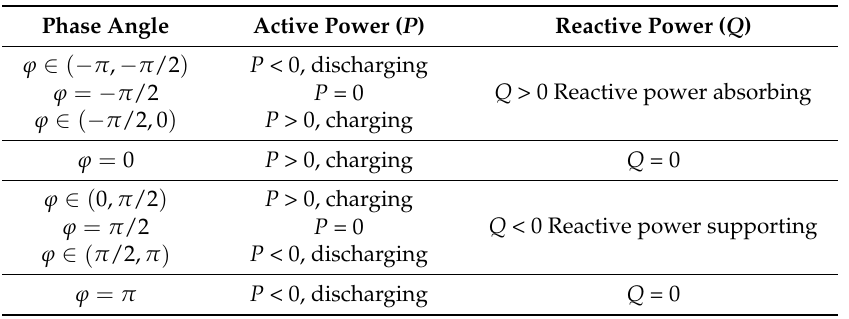
Table 1. The active and reactive power related to phase